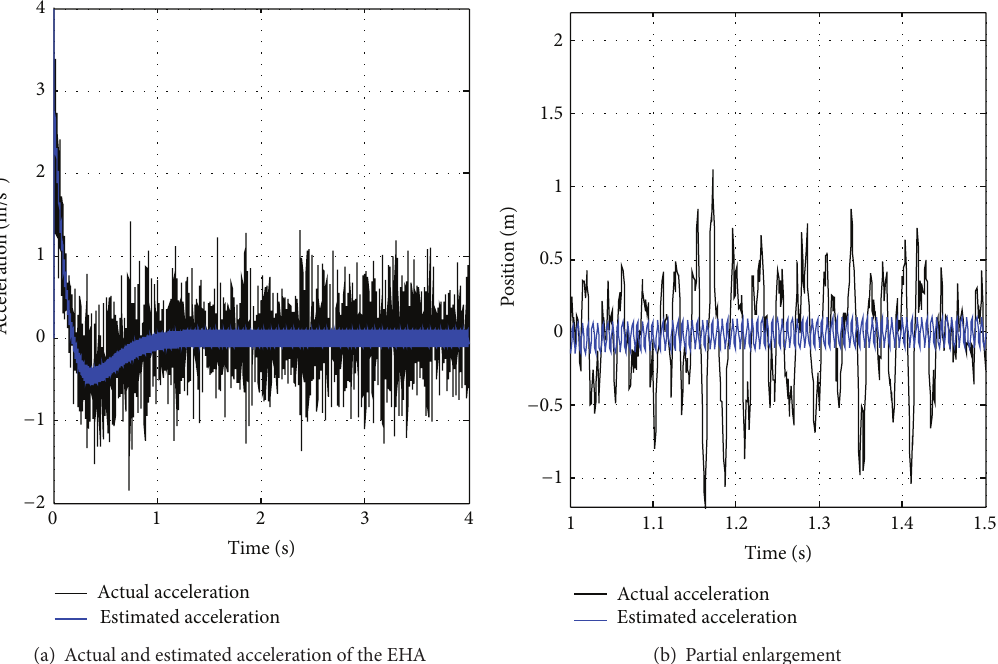
Figure 5: Actual and estimated acceleration of the EHA.